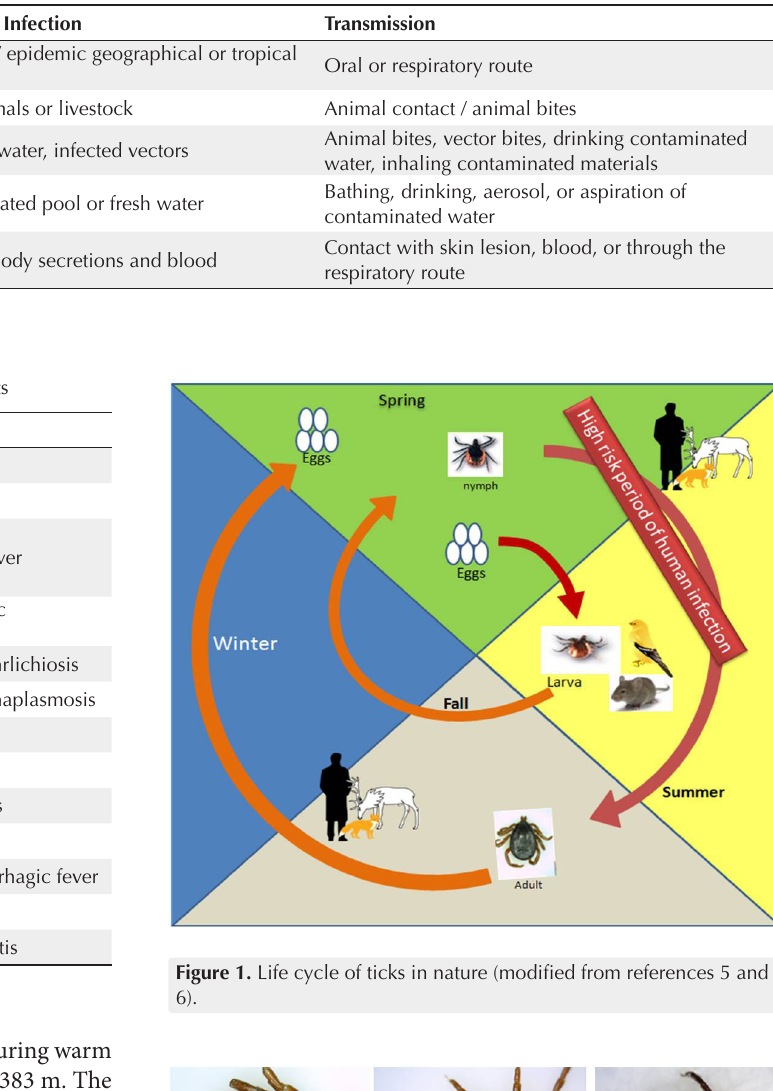
Table 1. General Recreational Activities and Associated Infection Risks a